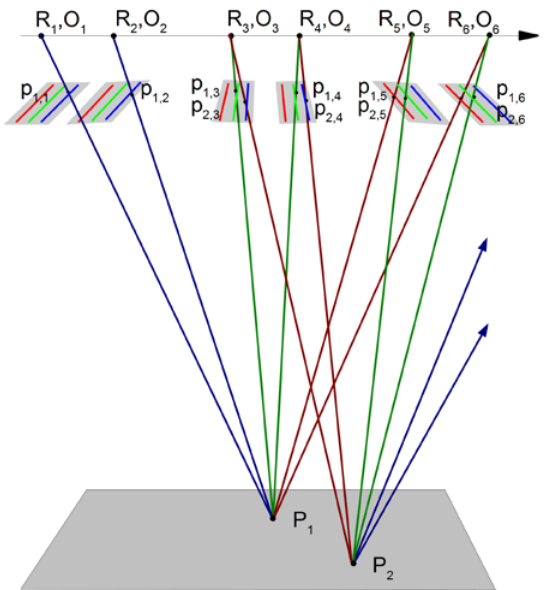
Figure 4: Visualization of the bundle adjustment problem for multi spectral line images. The arrow denotes the flight path during the capture of a line image, while the rotation R and position O of the camera change. The focal plane with three line sensors is shown in grey in front of the center of projection (dot on the flight path). The figure is not true to scale: The focal distance and the angular differences of the spectral bands are extremely